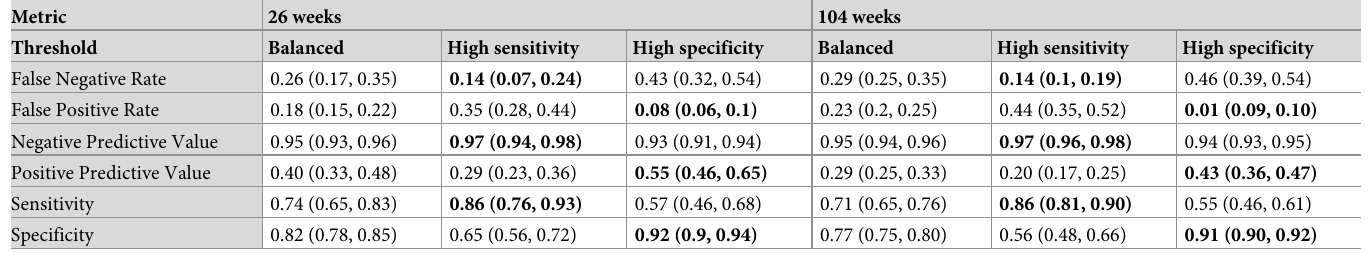
Table 1. Performance metrics of the combined prediction model for a timeframe of 26 and 104 weeks. Results using a threshold selected for high sensitivity ( > 80%), a threshold for high specificity ( > 90%), and one for a balanced case are presented.